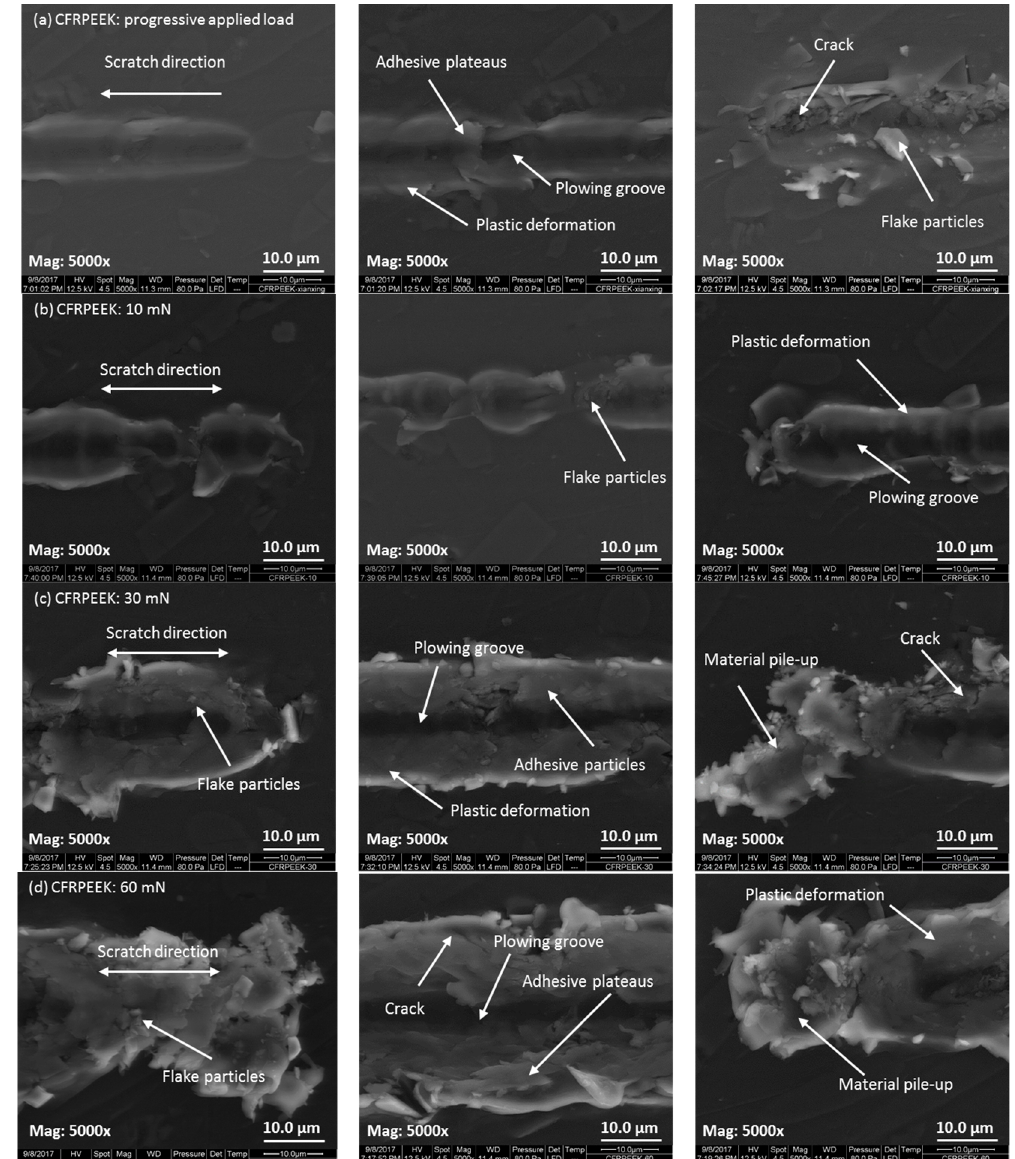
Figure 7. The morphologies of the worn surfaces observed by SEM for CFRPEEK with different applied loads: ( a ) progressive load with an initial load of 0.3 mN and a final load of 60 mN; ( b ) constant load of 10 mN; ( c ) constant load of 30 mN; and ( d ) constant load of 60 mN. The beginning, middle, and end of the wear scar are displayed in the left, middle, and right columns, respectively.